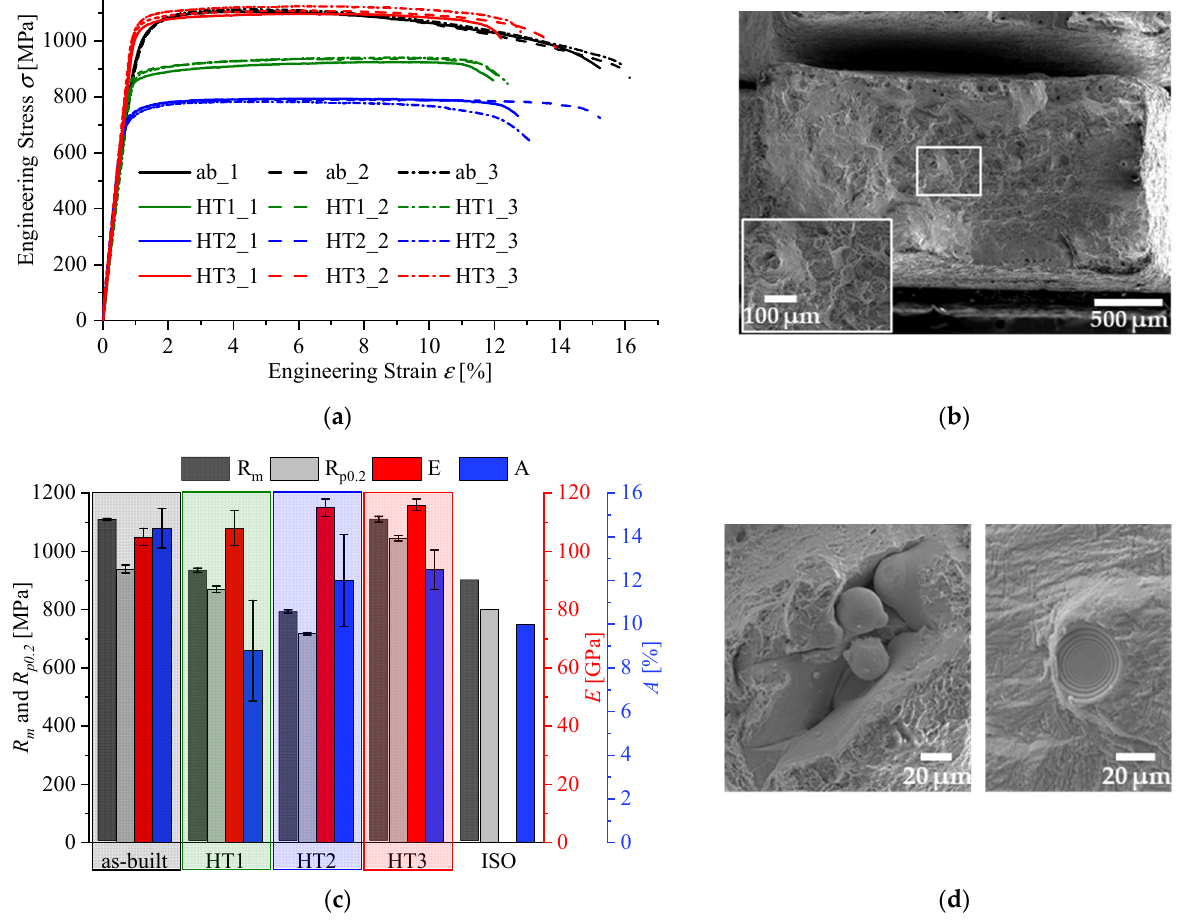
Figure 7. ( a ) Stress–strain curves of the as-built and heat-treated samples; ( b ) SEM images of the tensile fracture surface of an as-built Ti-6Al-7Nb specimen; ( c ) mechanical properties of the different conditions including minimum values for Ti-6Al-7Nb according to ISO 5832-11 (ISO) [92]; ( d ) SEM images of a characteristic LPBF defects, lack of fusion with unmelted powder particles (left) and gas pore (right), on a tensile fracture surface of an as-built Ti-6Al-7Nb specimen. The ε A -N f plots for the different conditions are approximated with the